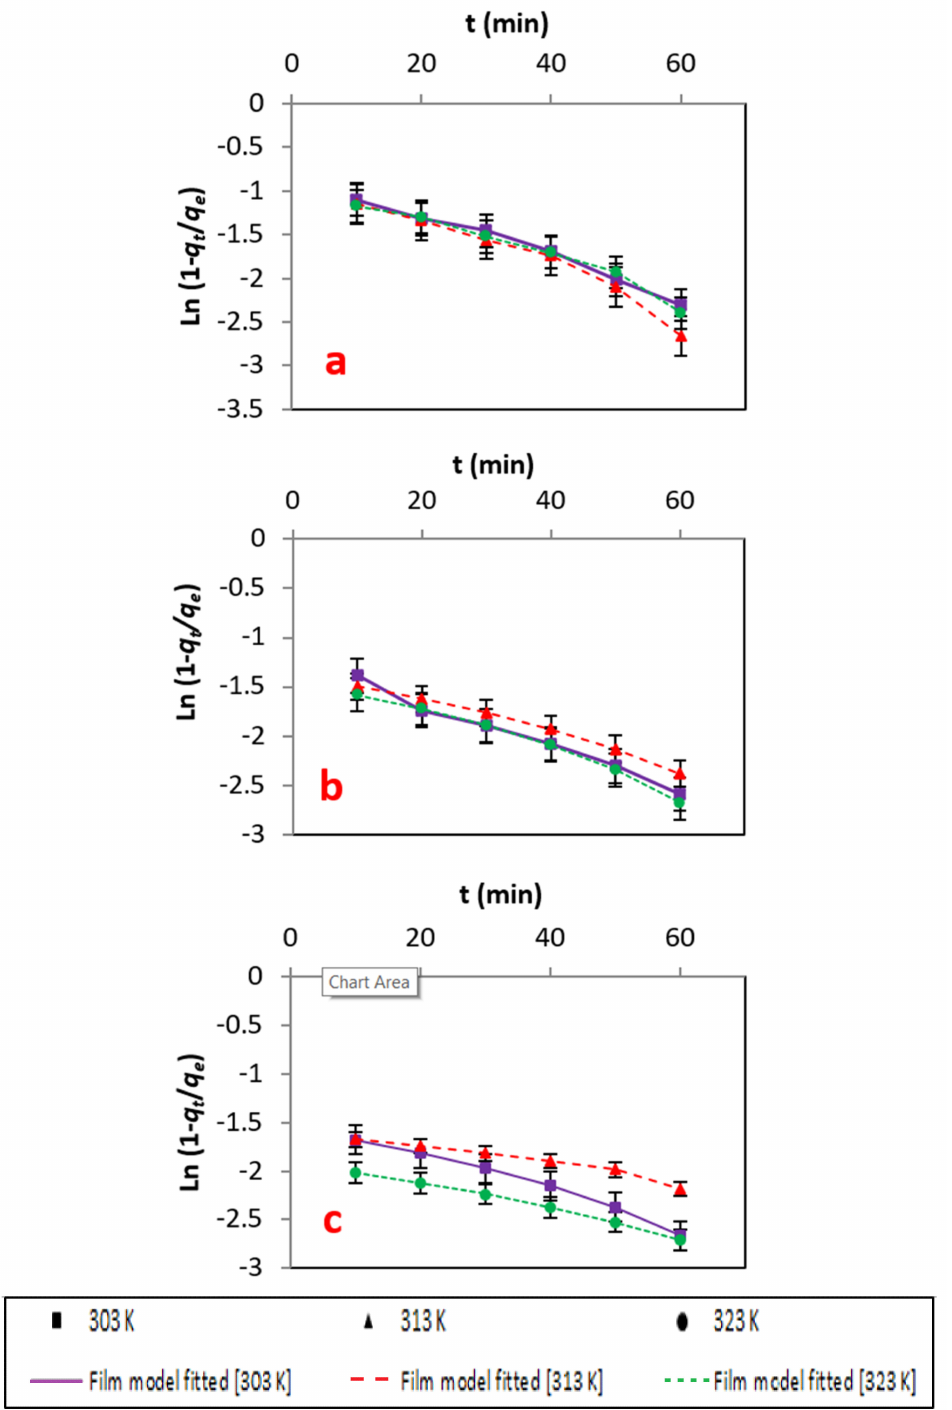
Figure 9. ( a – c ) Energy information fitted to the film diffusion model at different